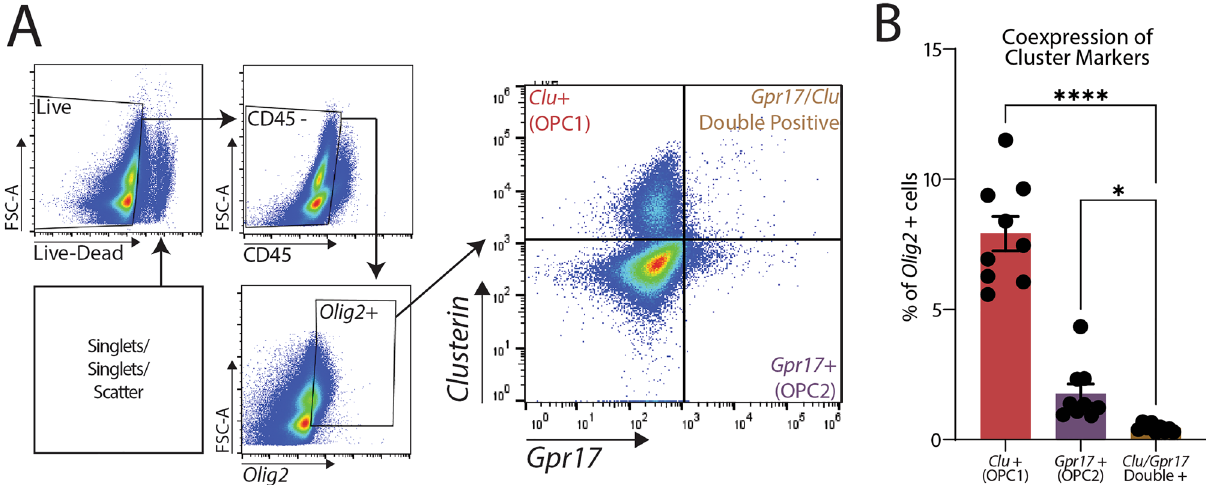
Figure 7. OPC clusters do not overlap in vivo. ( A ) Representative PrimeFlow gating of brain cells stained for CD45 protein and Clu , Gpr17 , Pdgfra , and Olig2 RNA (115,783 events plotted in Clusterin vs. Gpr17 plot). ( B ) Quantification of live/CD45−/Olig2+ cells that express Clu alone, Gpr17 alone, or both Clusterin and Gpr17 . N = 2 individual experiments, n = 9 biological samples (9 males). Analyzed using one-way repeated measures ANOVA with a Tukey’s pos-hoc test (F(2,8) = 90.85, p < 0.0001). *p < 0.05, ****p < 0.0001. Error bars represent SEM. All gates for RNA probes were drawn using fluorescence minus one (FMO)